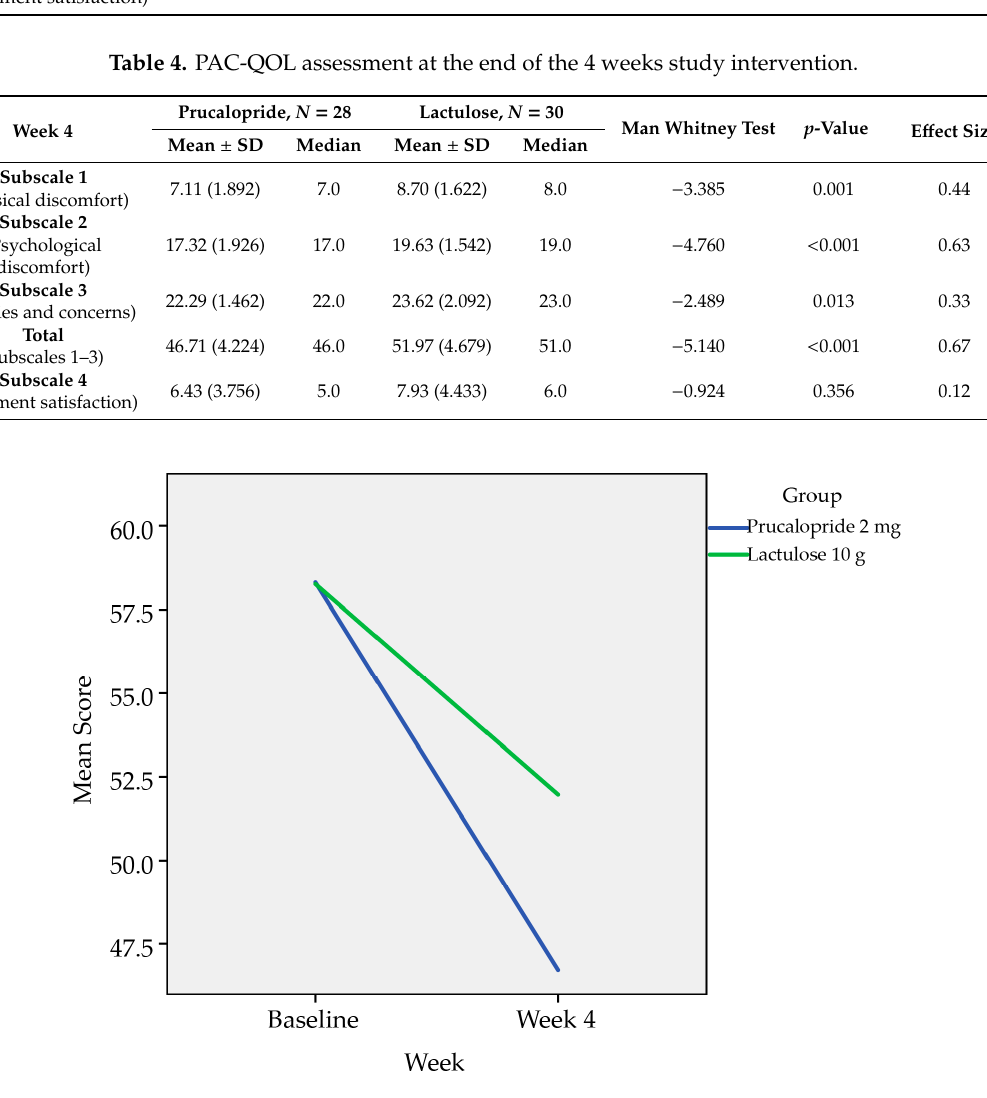
Figure 3. Repeated Measure ANOVA comparing the dissatisfaction subscales (subscales 1–3) from baseline to Week